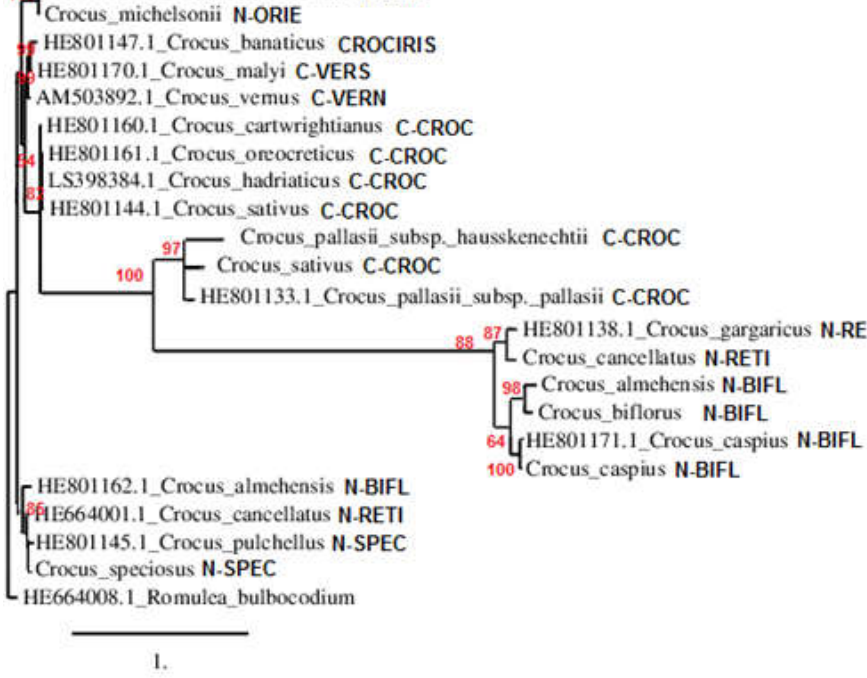
Fig. 1. The phylogenic tree derived from the analysis of ITS region data by the Bayesian method, the number above each branch shows the bootstrap